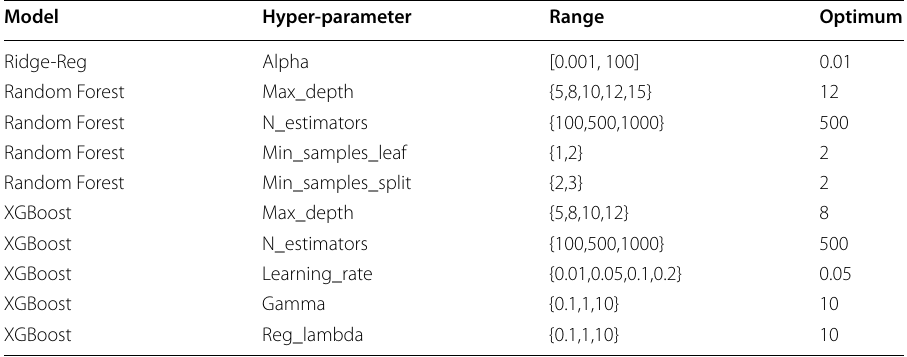
Table 2 Information about hyper-parameters related to Ridge-regression, Random Forest and XGBoost